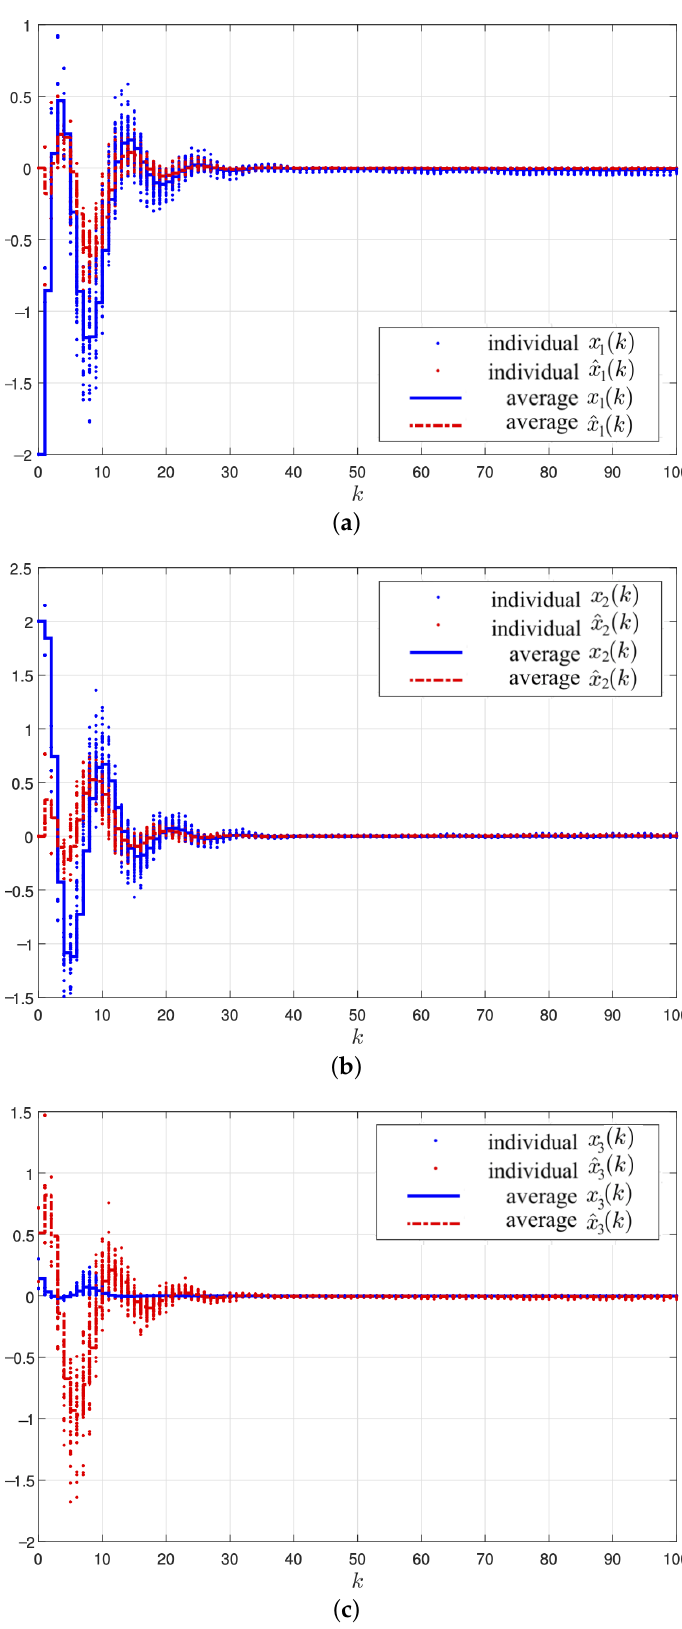
Figure 6. Trajectories of x 1 ( k ) and ˆ x 1 ( k ) ( a ), x 2 ( k ) and ˆ x 2 ( k ) ( b ), and x 3 ( k ) and ˆ x 3 ( k ) ( c